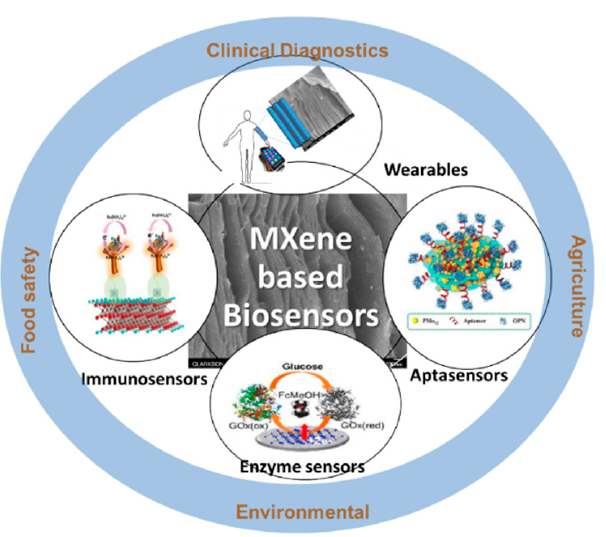
Figure 2. Summary of different classes of biosensing platforms based on MXenes and their applications. Immunosensors (reprinted with permission from [62]) Aptasensors (reprinted with permission from [63]), Enzyme sensors (reprinted with permission from